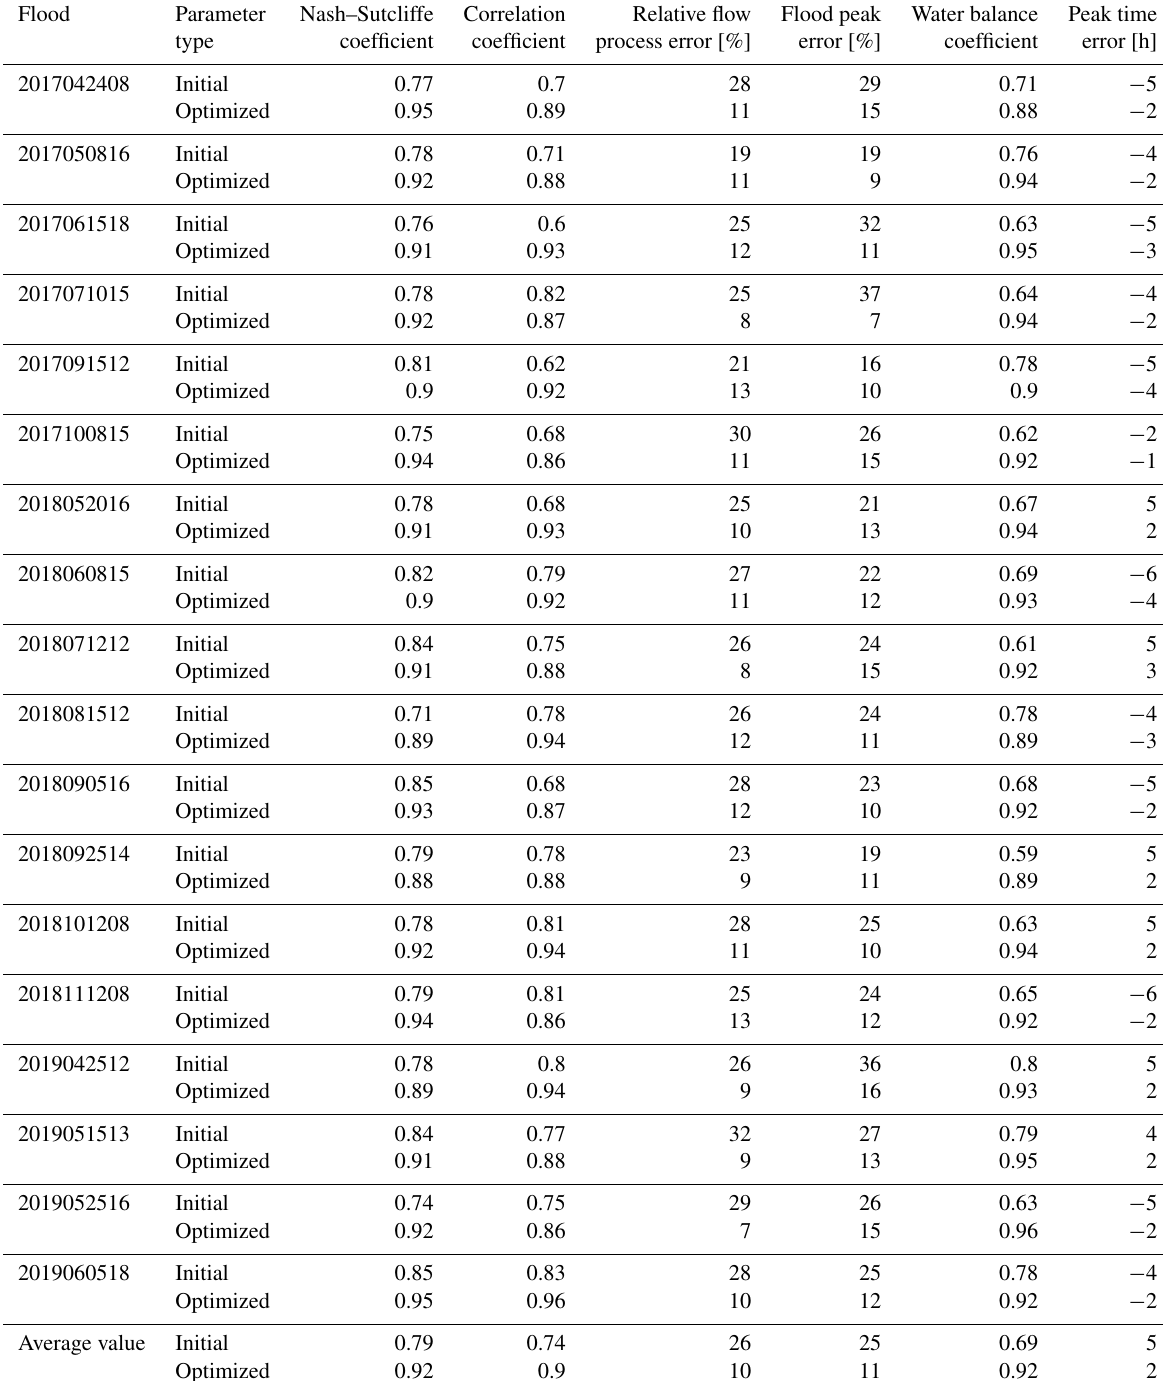
Table 4. Flood simulation indices for model